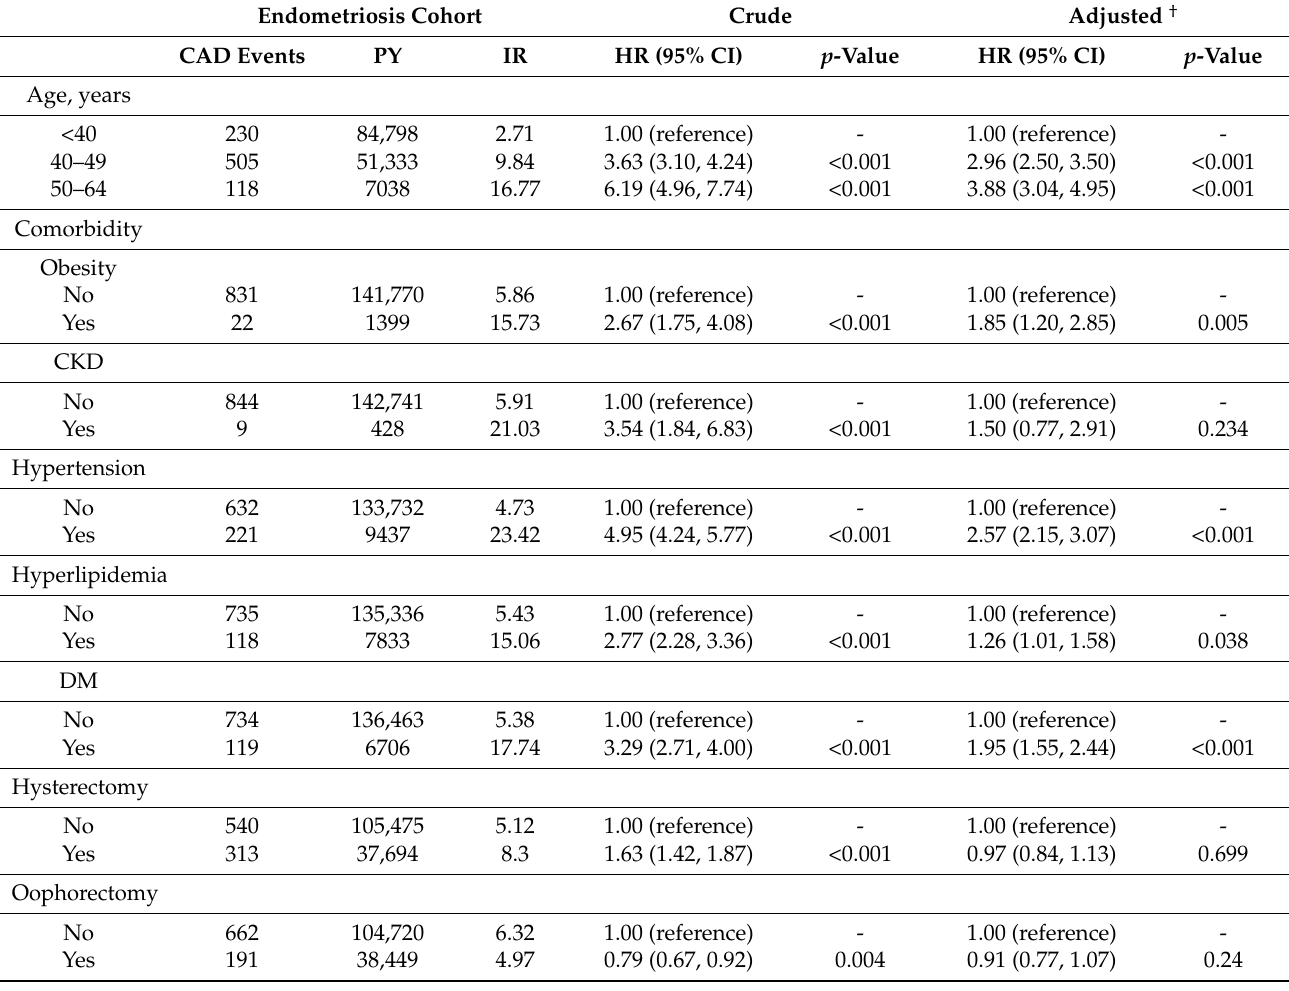
Table 4. Comparison of the incidence rates and hazard ratios of CAD in endometriosis patients stratified by age, comorbidi- ties, and